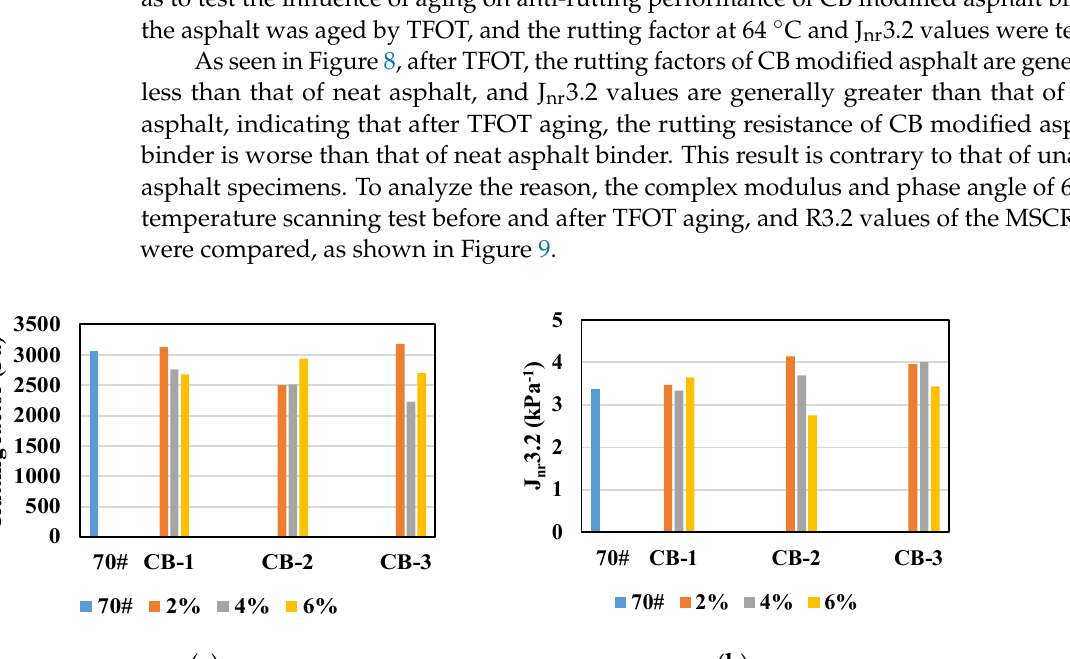
Figure 7. Fatigue performance parameter s of unaged asphalt specimens.